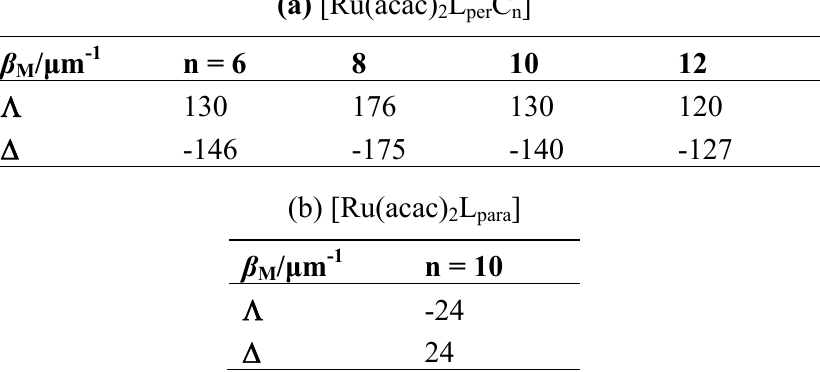
Table 2. Values for HTP ( β L ] in MBBA. This table is modified one from reference [Ru(acac) 2 para